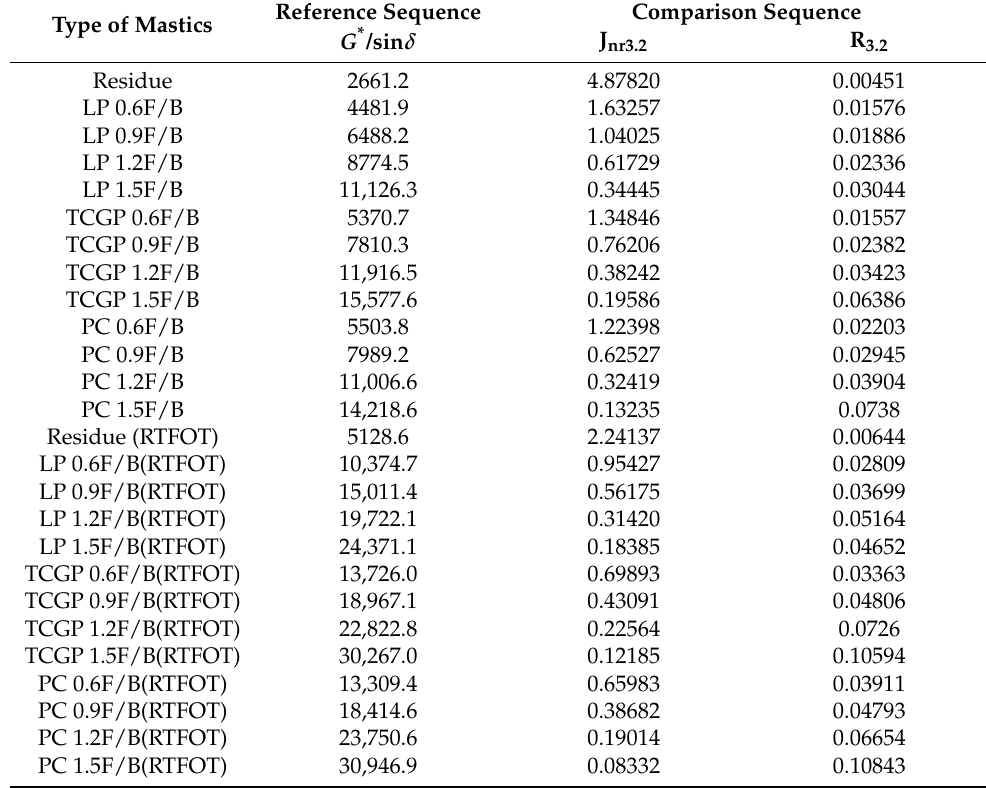
Table 7. Original data of rheological properties of emulsified asphalt